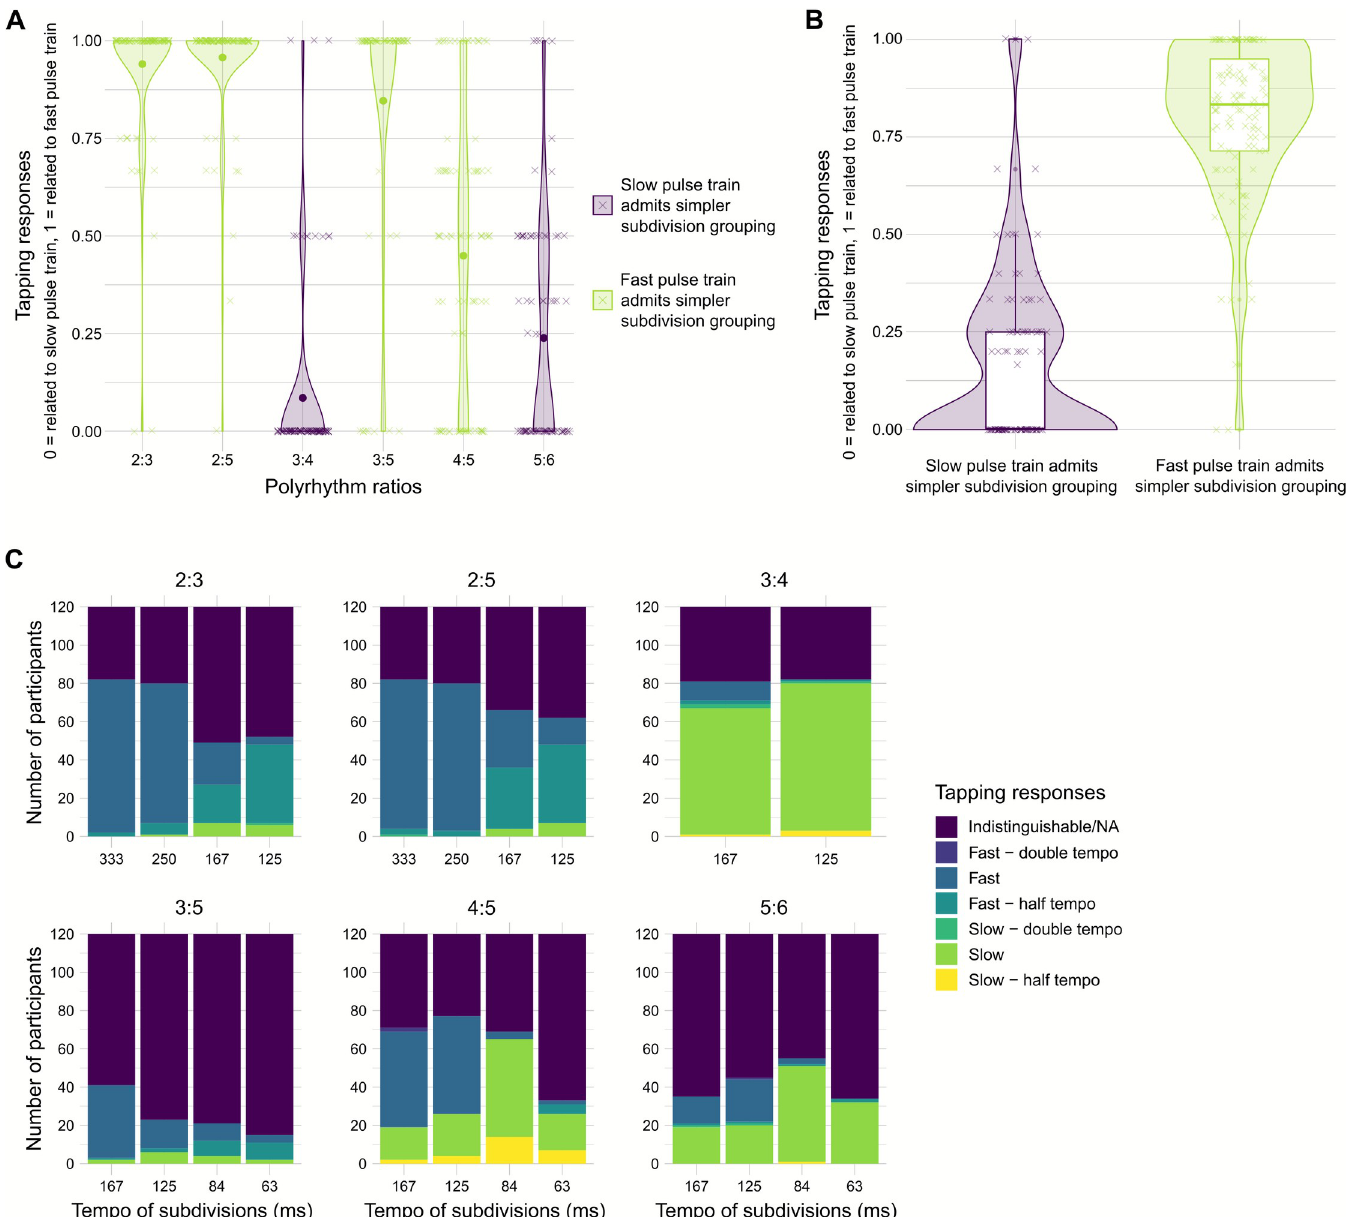
Fig 5. Tapping responses of the experiment presenting polyrhythms of different ratios. A) The dependent variable coded preferences for tapping in relation to the slow (0) or fast (1) pulse train. Mean across tempi are shown per participant ( × ) and as grand means for each ratio (•). Tapping preferences were expected to be related to the slow pulse train in polyrhythms that admit simpler subdivision in the slow pulse train (dark purple) and to the fast pulse train in polyrhythms that admit simpler subdivision in the fast pulse train (bright green). B) Mean per participant for polyrhythms that admit simpler subdivision in the slow pulse train (3:4, 5:6) in dark purple and polyrhythms that admit simpler subdivision in the fast pulse train (2:3, 2:5, 3:5, 4:5) in bright green. C) Metrical categories of the tapping responses for the individual tempi in each of the polyrhythm ratios. The category “Indistinguishable /NA” includes consistent tapping to the cycle and subdivision levels and to the polyrhythm itself as well as inconsistent and no